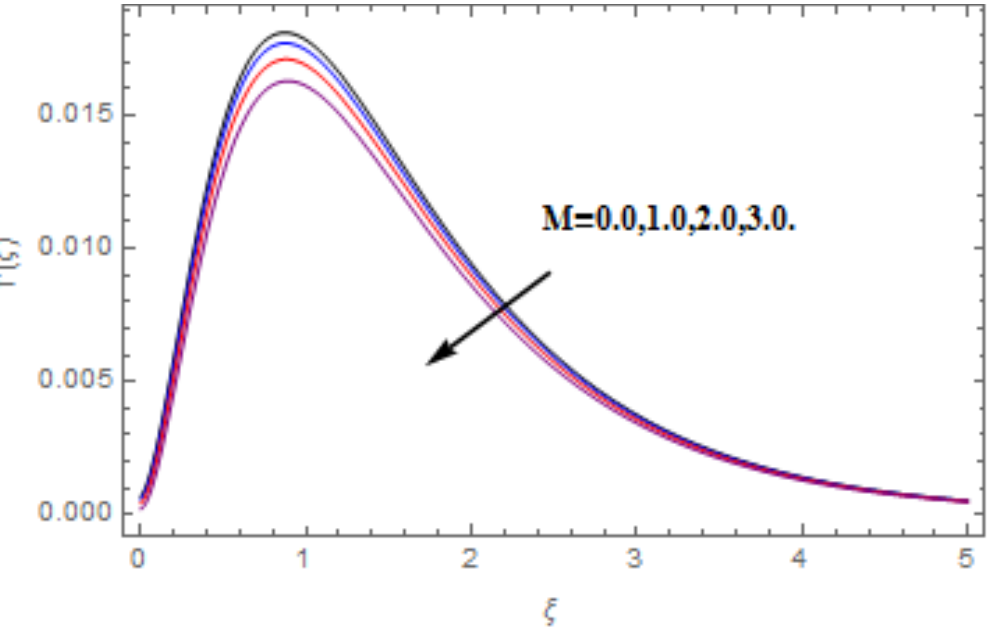
Figure 4. Varation in f (cid:48) ( ξ ) against M , when ψ = 0.2, Nt = Nb = 0.5, Le = 1.0, Ec = 1.0, Pr = 1.2, γ = 0.1, κ = 0.2,